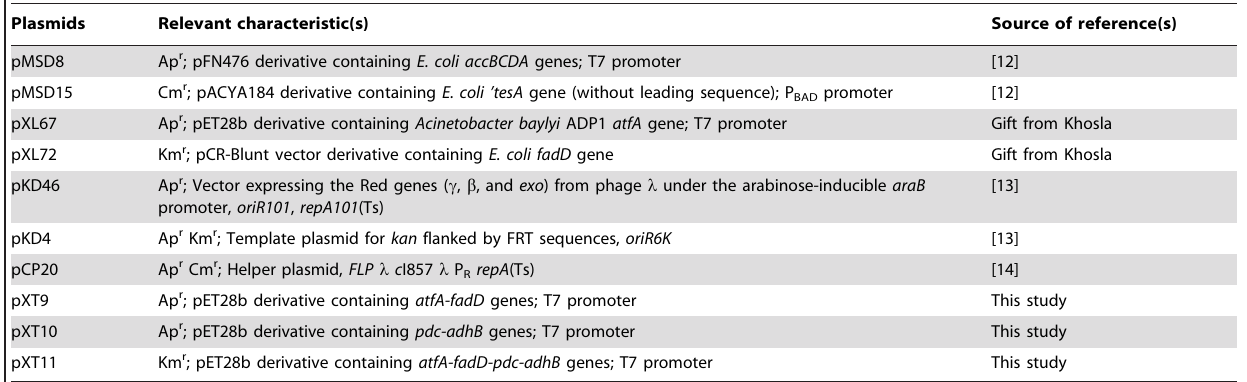
Table 2. Plasmids constructed and used in this study.